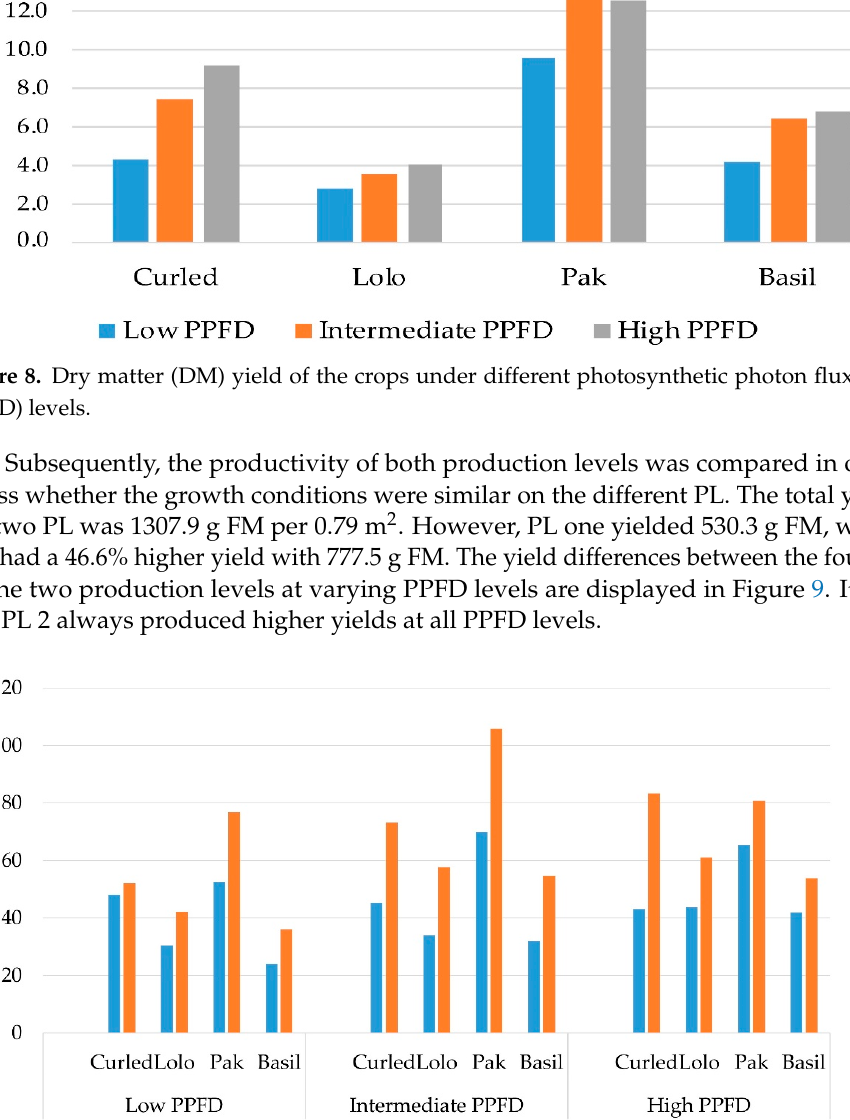
Table 9. Results of two-tailed paired t -test ( p < 0.05).